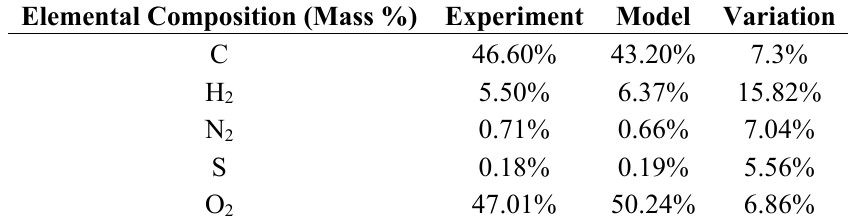
Table 6. Comparison between elemental compositions of MGW experimental results and model